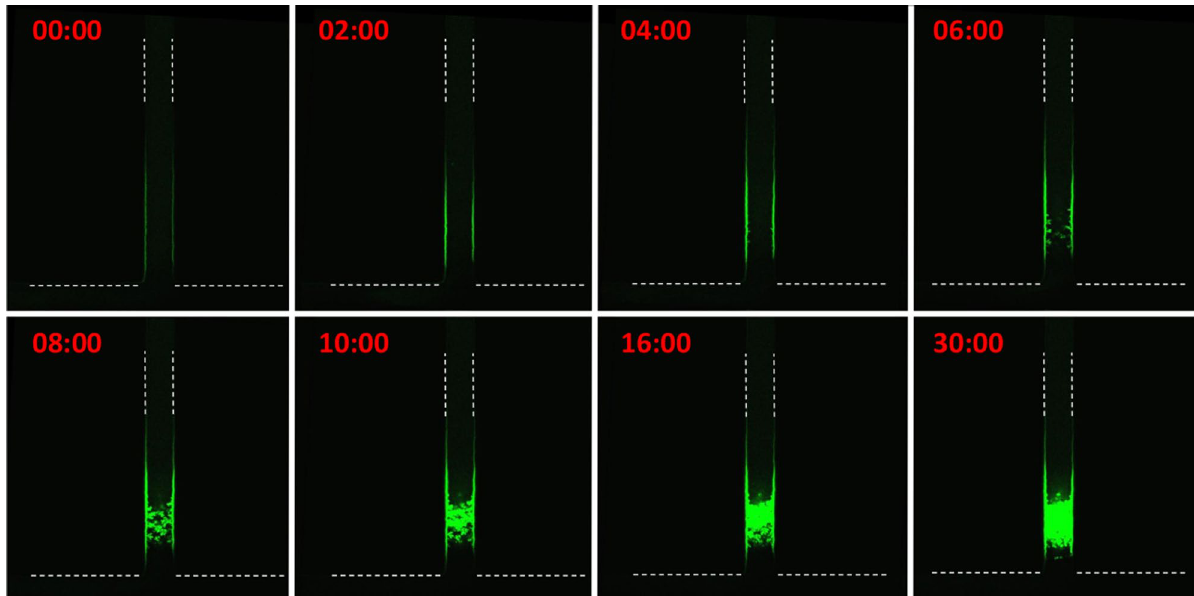
Figure 3. Confocal microscopy images obtained as optical sections located in the middle of the channel showing time-dependent apparition of fluorescent aggregates at 488 nm within 50 µm sweat channel at different times in min following contact of the two fluids using artificial sweat containing 0.1% FITC-BSA. Same flow conditions as in Fig. 2a caption. Dotted white lines delimit the contour of channel walls where no fluorescence is detected. Fluorescence aggregates appear in